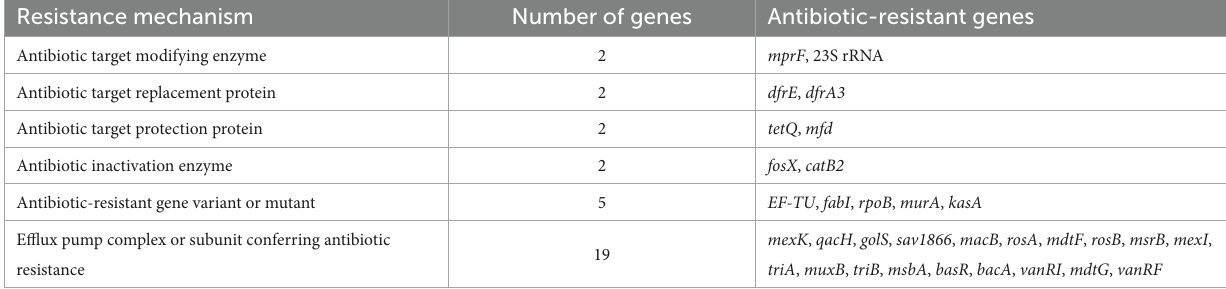
TABLE 3 Classification of antibiotic resistance genes of Brucella isolates (similarity